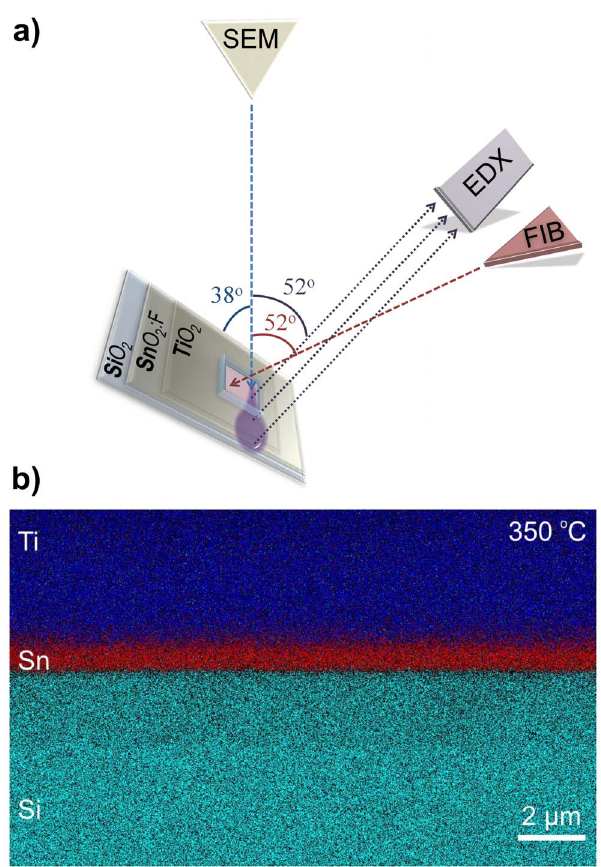
Figure 6. The schematic of the EDX setup geometry (a) and an example of the EDX analysis (b) used to reveal the elemental layer composition (Ti, Sn, Si) for the sintering temperature range of 350–550 6